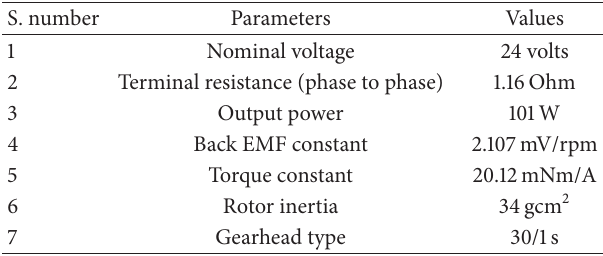
Table 4: Specifications of BLDC motor.